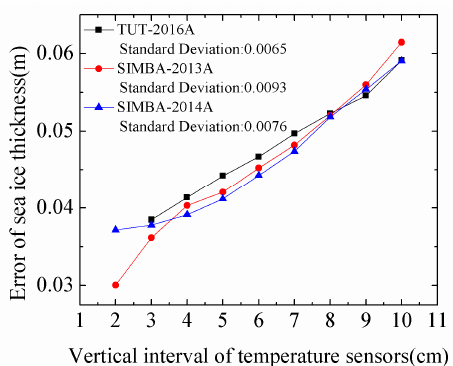
Figure 11. The estimated errors of ice thickness against the resampled interval of the ice temperature profile. TUT-2016A, SIMBA-2013A, SIMBA-2014A have initial vertical intervals of 0.03 m and 0.02 m, respectively.